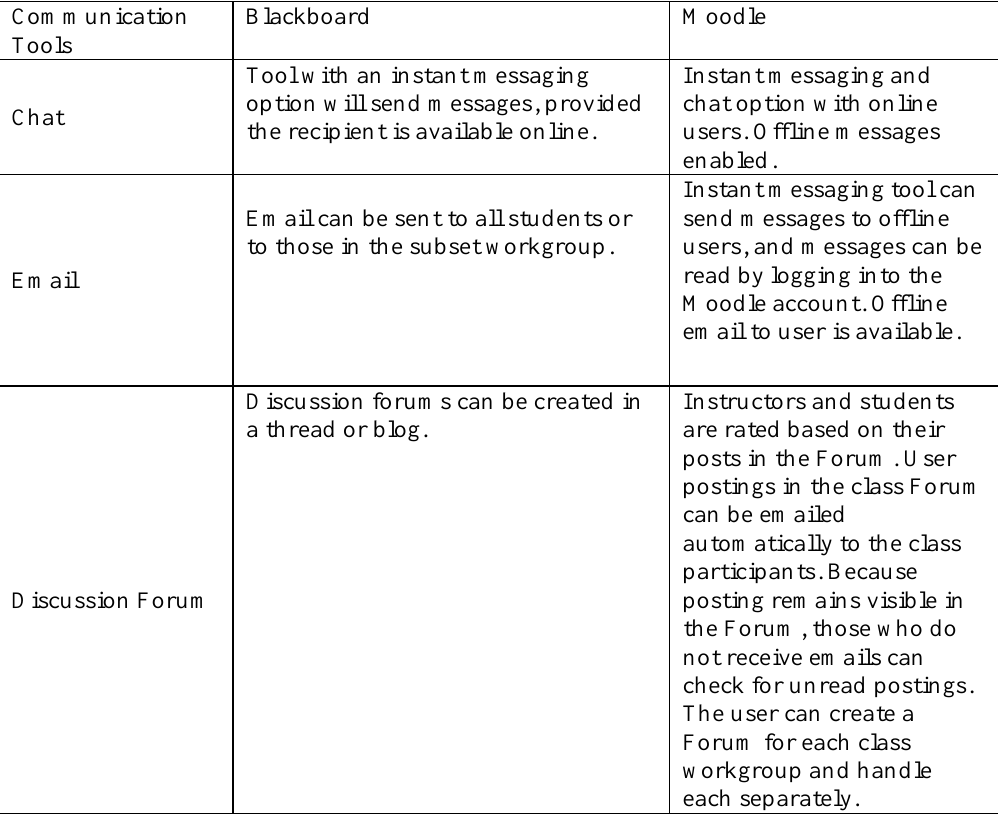
Comparison between Blackboard and Moodle Communication Blackboard Moodle Tools Tool with an instant Chat